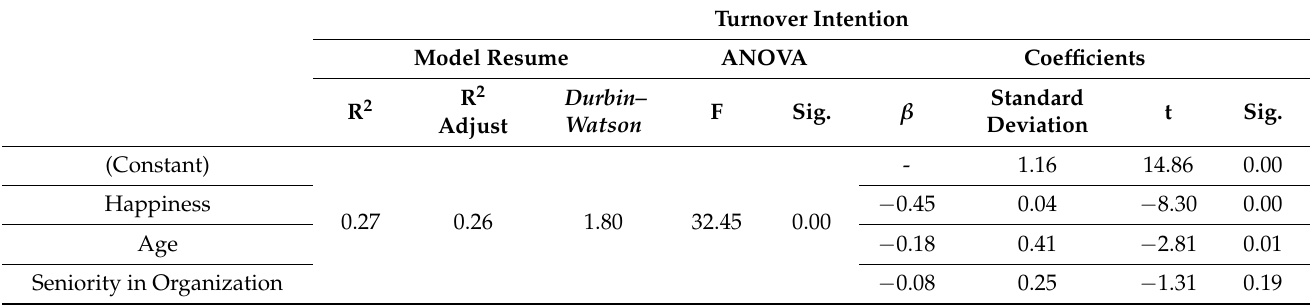
Table 4. Regression (X = Happiness and Y = Turnover Intention).